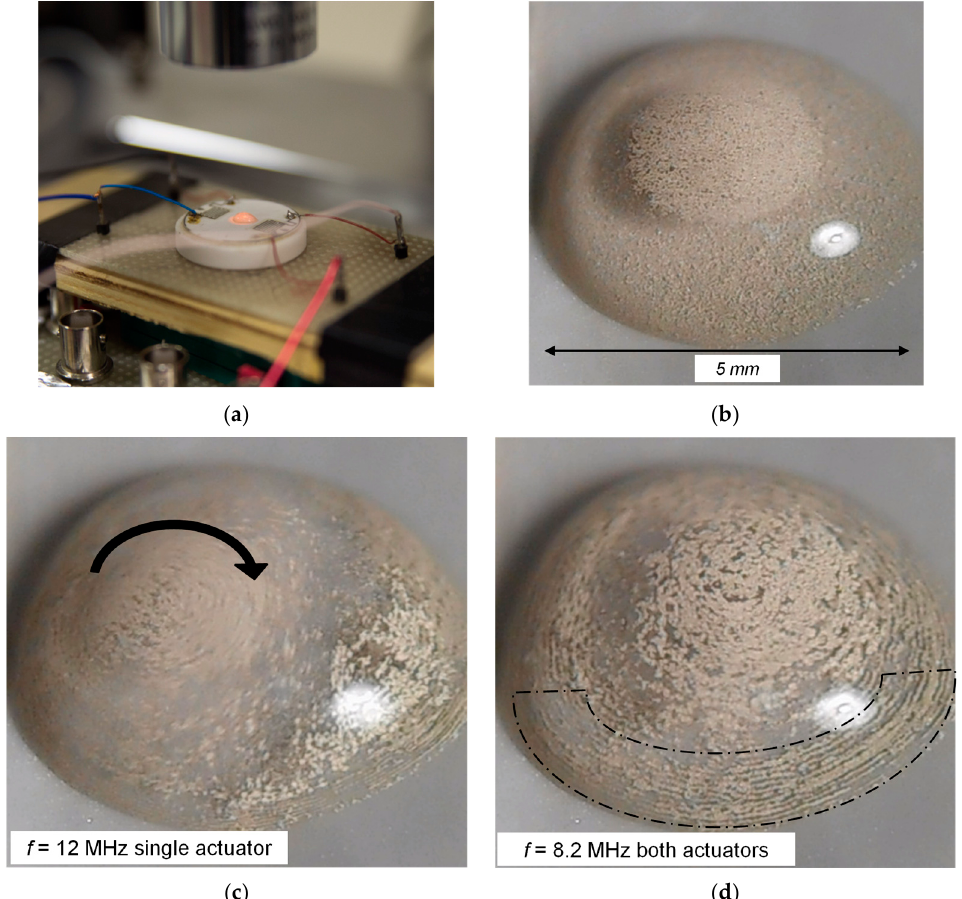
Figure 3. ( a ) Experimental setup showing the device placed under the microscope; Pictures of a water drop with dispersed light-reflective particles with a 25- μ m diameter: ( b ) no actuation; ( c ) vortex rotation caused by exciting one single actuator at 12 MHz; ( d ) particle accumulation on circular lines with both the actuators excited at 8.2 MHz and a phase difference of